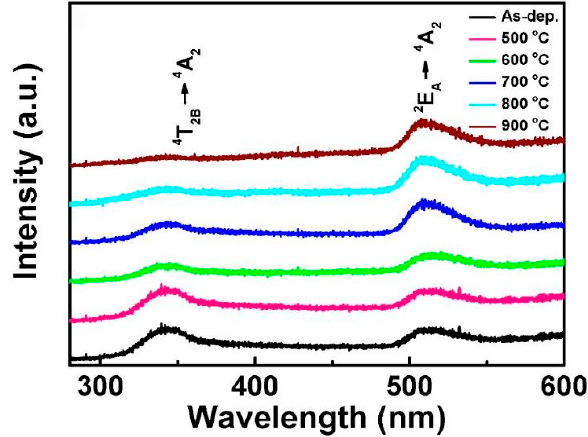
Figure 16. Photoluminescence spectra of ZnGa 2 O 4 films annealed at different temperatures [74].